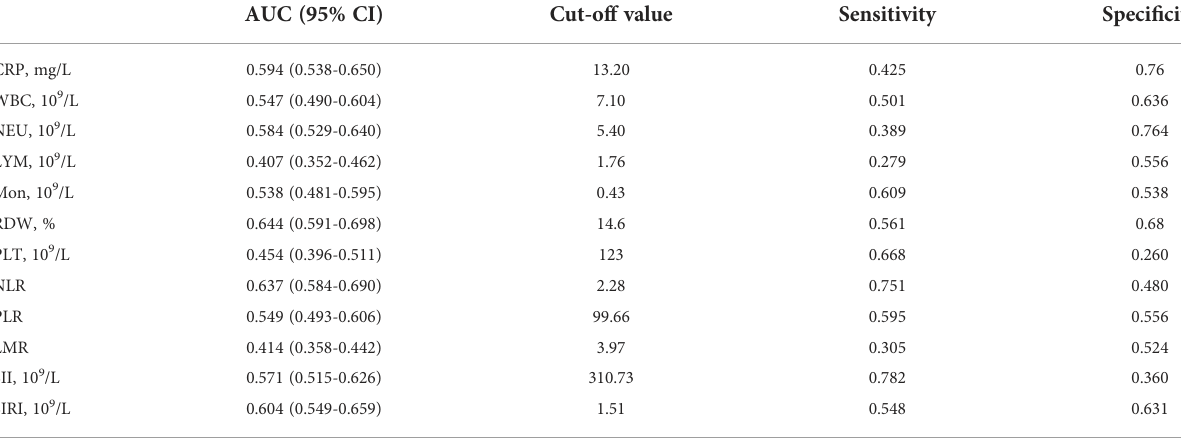
TABLE 2 Area under the curve (AUC) and optimal threshold for in fl ammatory biomarkers to predict 3-year all-cause mortality in patients with